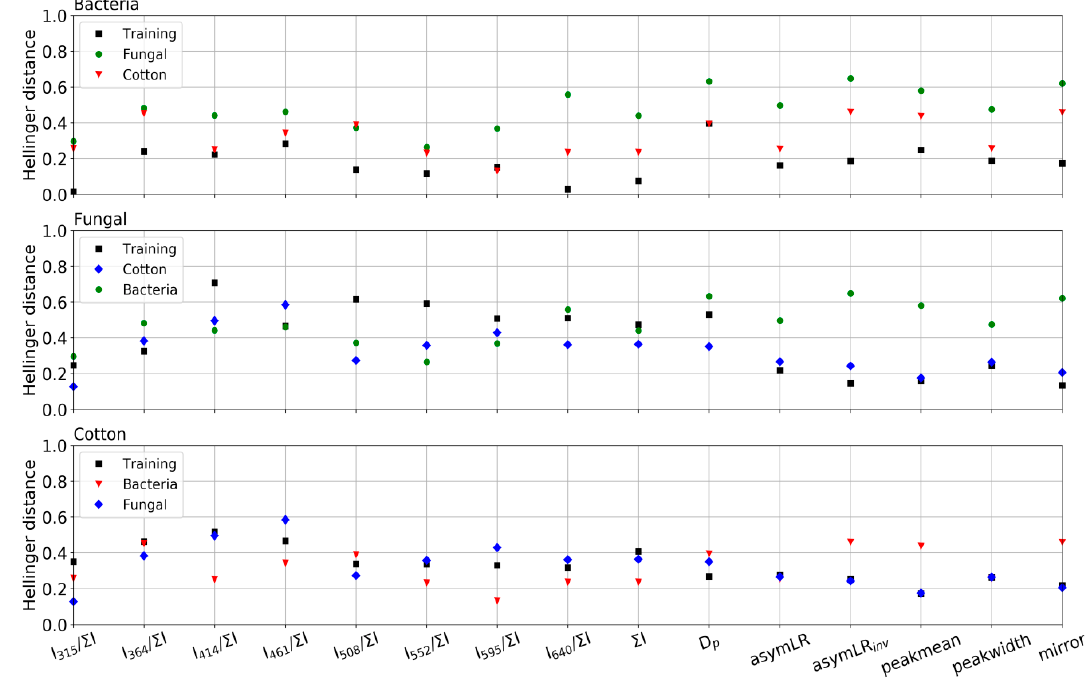
Figure 5. Comparison of inter-class similarity. Hellinger distances for each parameter comparing the ambient classes to one another and also to their respective ACS training data. Top: Bacteria-like; Middle: Fungal-like; Bottom: Cotton-like. Ambient data is selected using an assignment probability of p > 0.9.